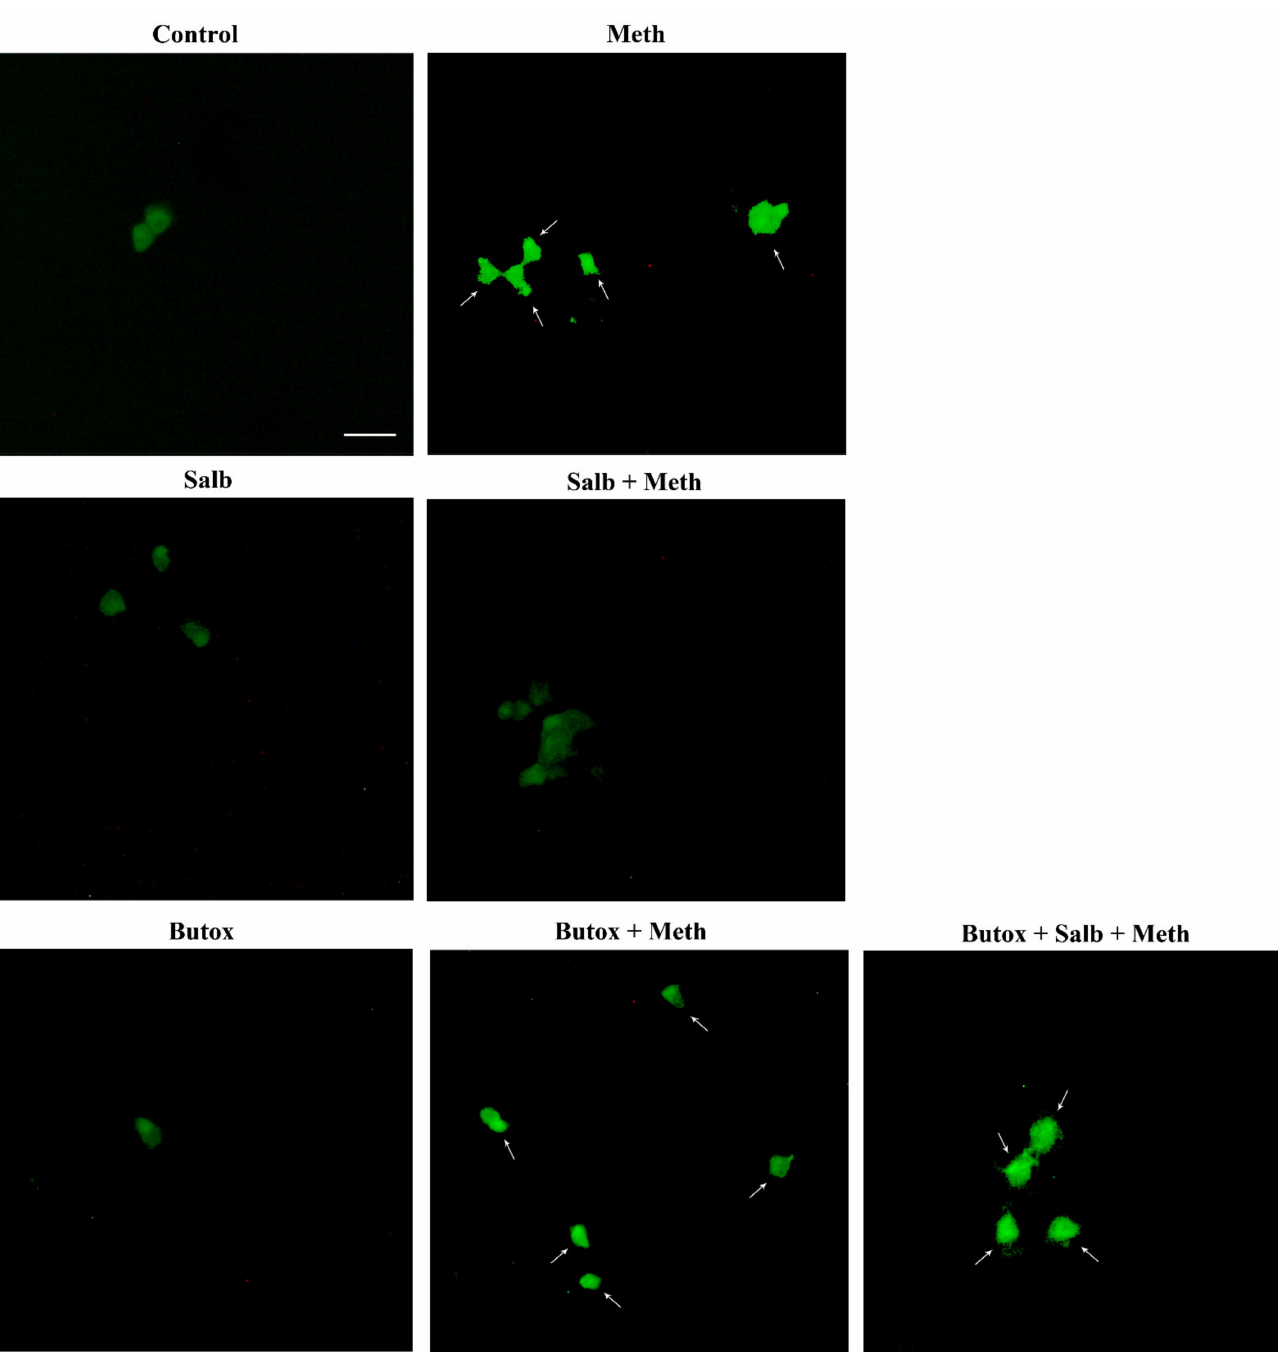
Figure 6. The β 2-AR agonist (salbutamol) protects against Meth toxicity, while the β 2-AR antagonist (butoxamine) impedes such a protection (FJB staining). Representative pictures show that salbutamol (5 µ M) protects against Meth-induced toxicity. In fact, intensely fluorescent Meth-treated PC12 cells turn out into dark cells when salbutamol is pre-administered. This β 2-AR agonist is no longer protecting when the selective β 2-AR antagonist (butoxamine) is administered. In fact, cells administered salbutamol + butoxamine + Meth revert into intensely yellow fluorescence. Arrows indicate FJB intensely positive cells. Scale bar = 20 µ